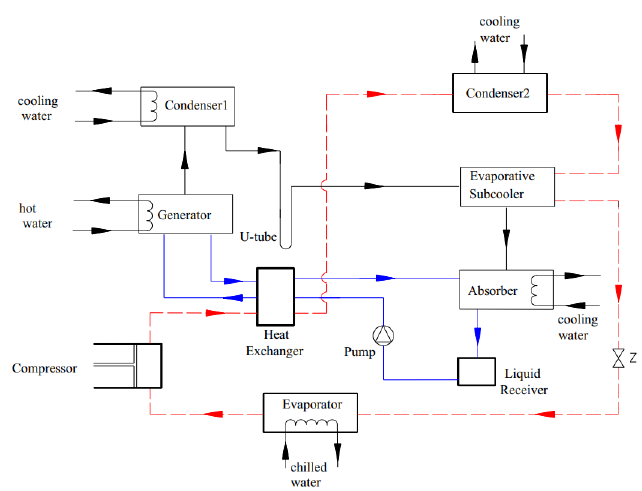
Figure 5. The process of CACRS [62]. Reproduced with permission from [Elsevier], Elsevier, 2020.